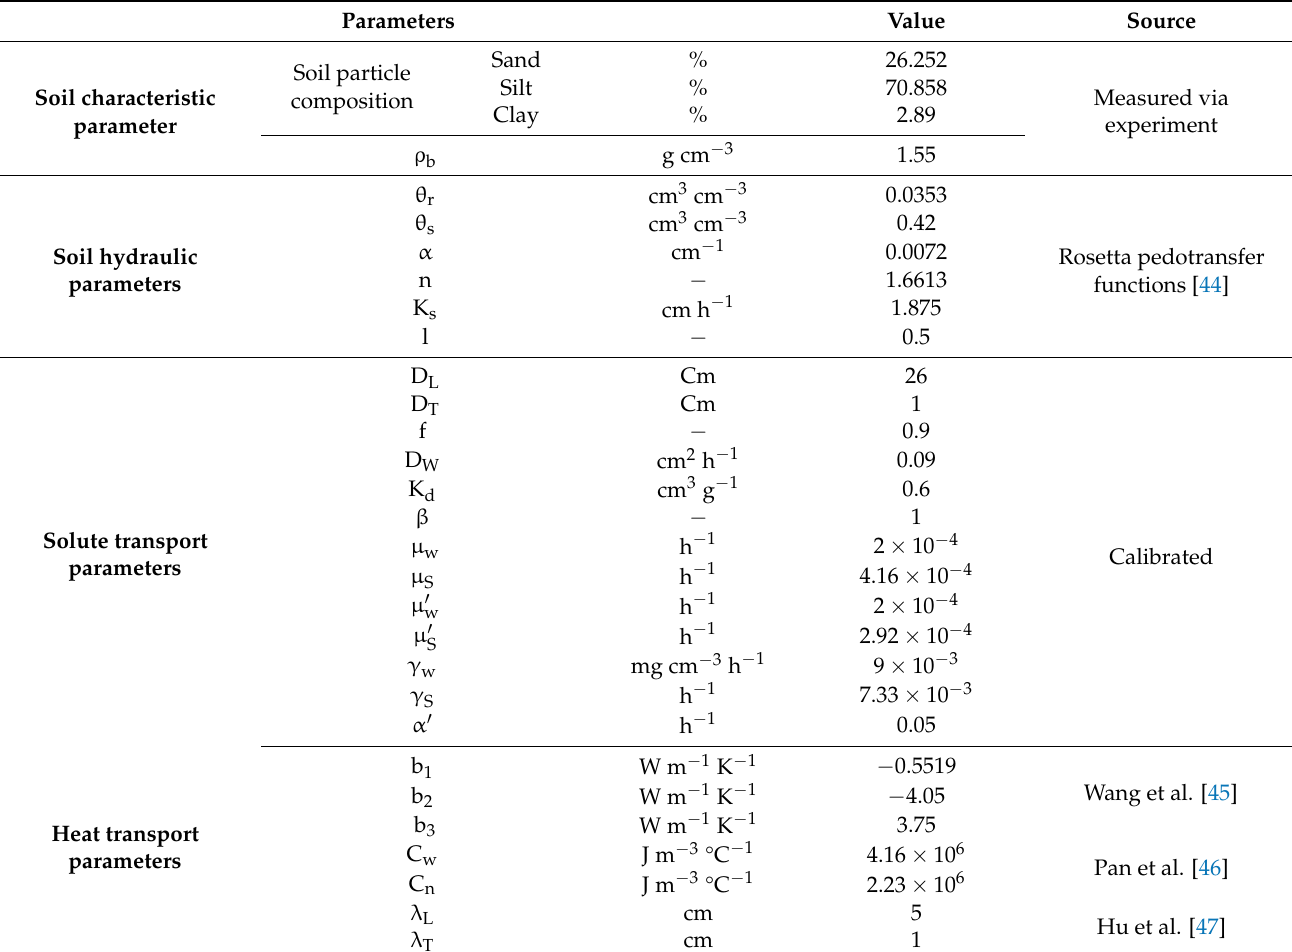
Table 2. Values of soil parameters for water, salt, and heat transport under partially mulched conditions with drip